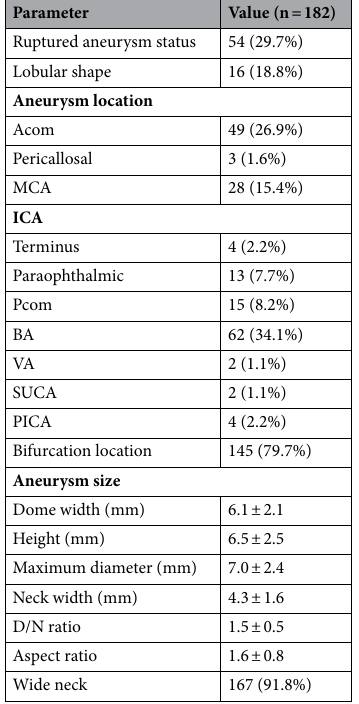
Table 1. Baseline aneurysm characteristics. Acom anterior communicating artery, PA pericallosal artery, MCA middle cerebral artery, ICA internal carotid artery, Pcom posterior communicating artery, BA basilar artery, VA vertebral artery, SUCA superior cerebellar artery, PICA posterior inferior cerebellar artery, D/N ratio dome-to- neck